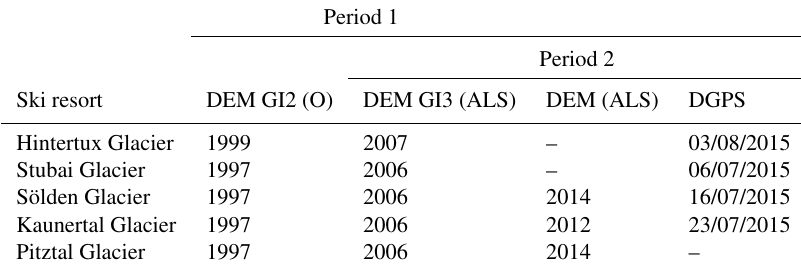
Table 2. Dates of the surface elevation information in the different glacier ski resorts from digital elevation models (DEM) based on or- thophotos (O), airborne laser scanning surveys (ALS), and differential GPS measurements (DGPS).